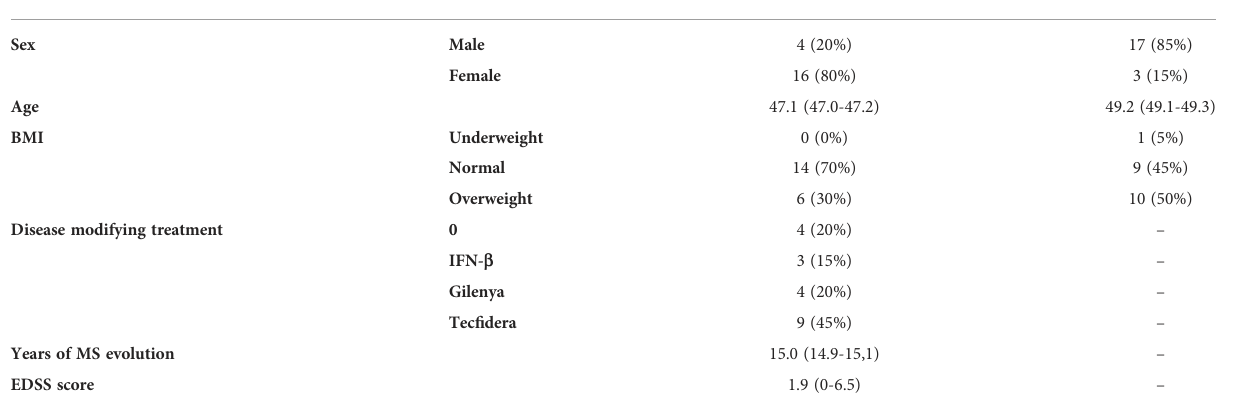
TABLE 1 Clinical and demographic data of the studied